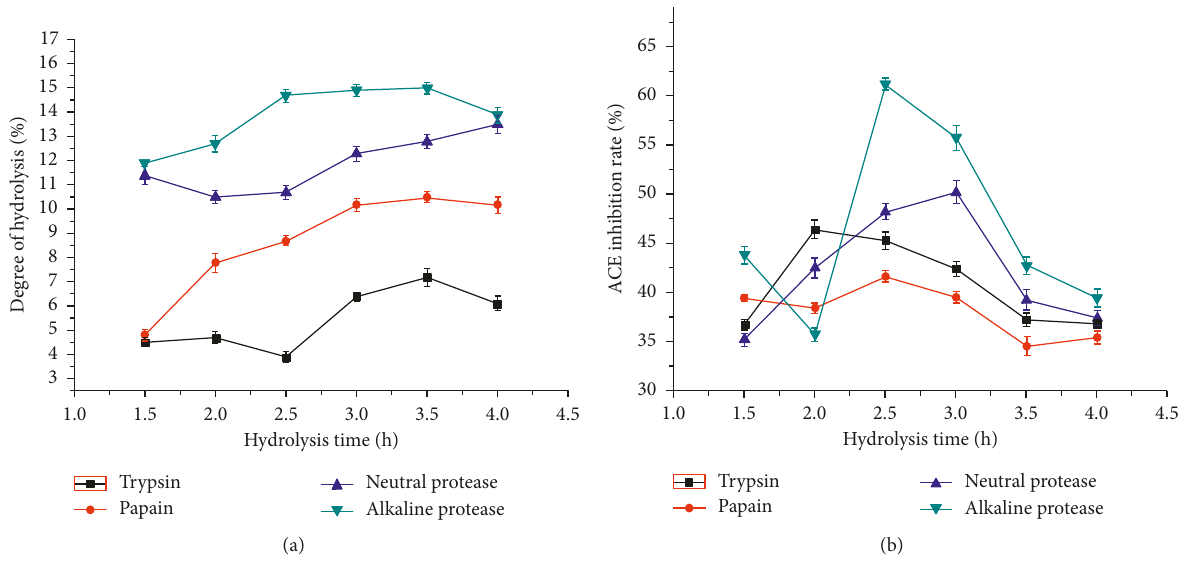
Figure 1: Effect of enzymes and hydrolysis time on properties of protein from COASM: (a) DH; (b) ACE inhibition